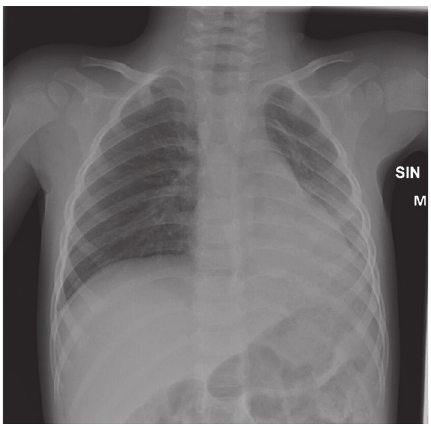
Figure 1: Chest X-ray at arrival, showing infiltrates and/or atel- ectasis in the left lower